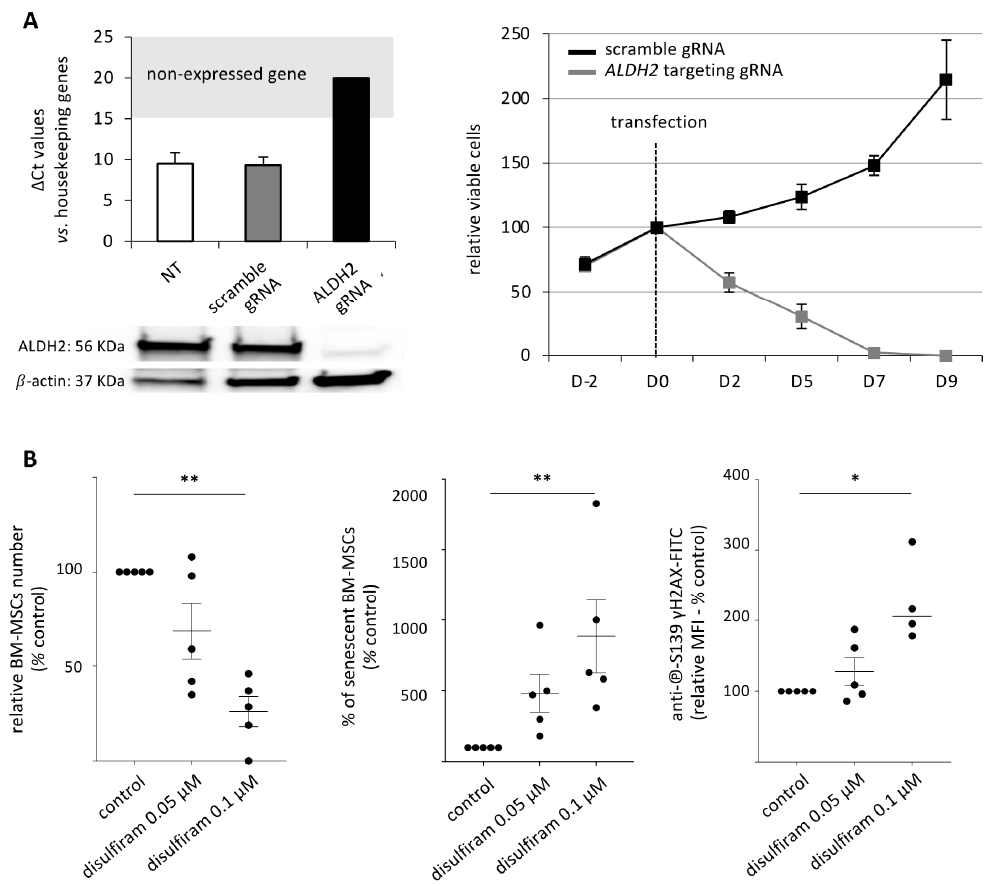
Figure 4. ALDH2 inhibition reproduces the consequences of pesticide exposure on BM-MSCs. ( A ) CrispR Cas9 based ALDH2 invalidation was checked by RT-qPCR and western blot analyses (left panel). ALDH2 invalidation in BM-MSCs induces cell death (right panel), ruling out the use of this strategy in the model. ( B ) Disulfiram, an inhibitor of ALDH2 activity, decreases the relative BM-MSCs number ( n = 5), increases senescence ( n = 4) and double strand DNA damage ( n = 5), as quantified by anti- ℗ -S139 γ H2AX immunoreactivity. Data are expressed as percent of the control ± SEM; *, p < 0.05; **, p < 0.01; Friedman followed by post hoc Dunn’s multiple comparisons test. The uncropped western blot images can be found in Figure S5.